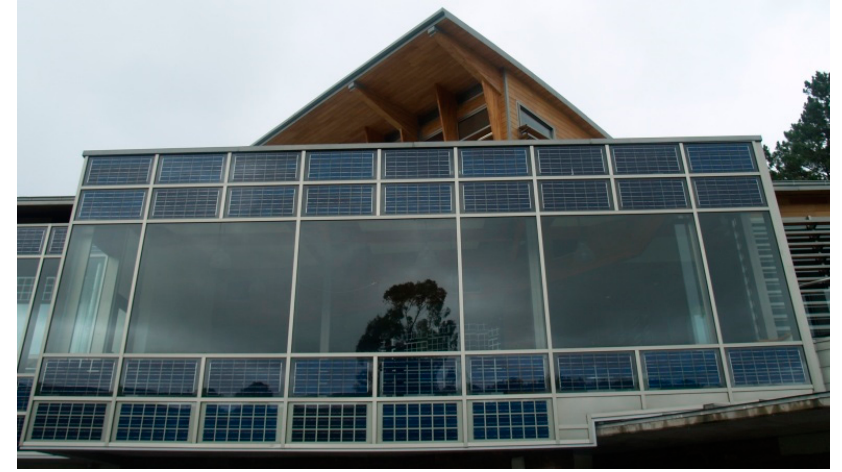
Figure 1. Demonstration container with attached sunspace (south side) located at San Pedro de Anes, Asturias (northern Spain).